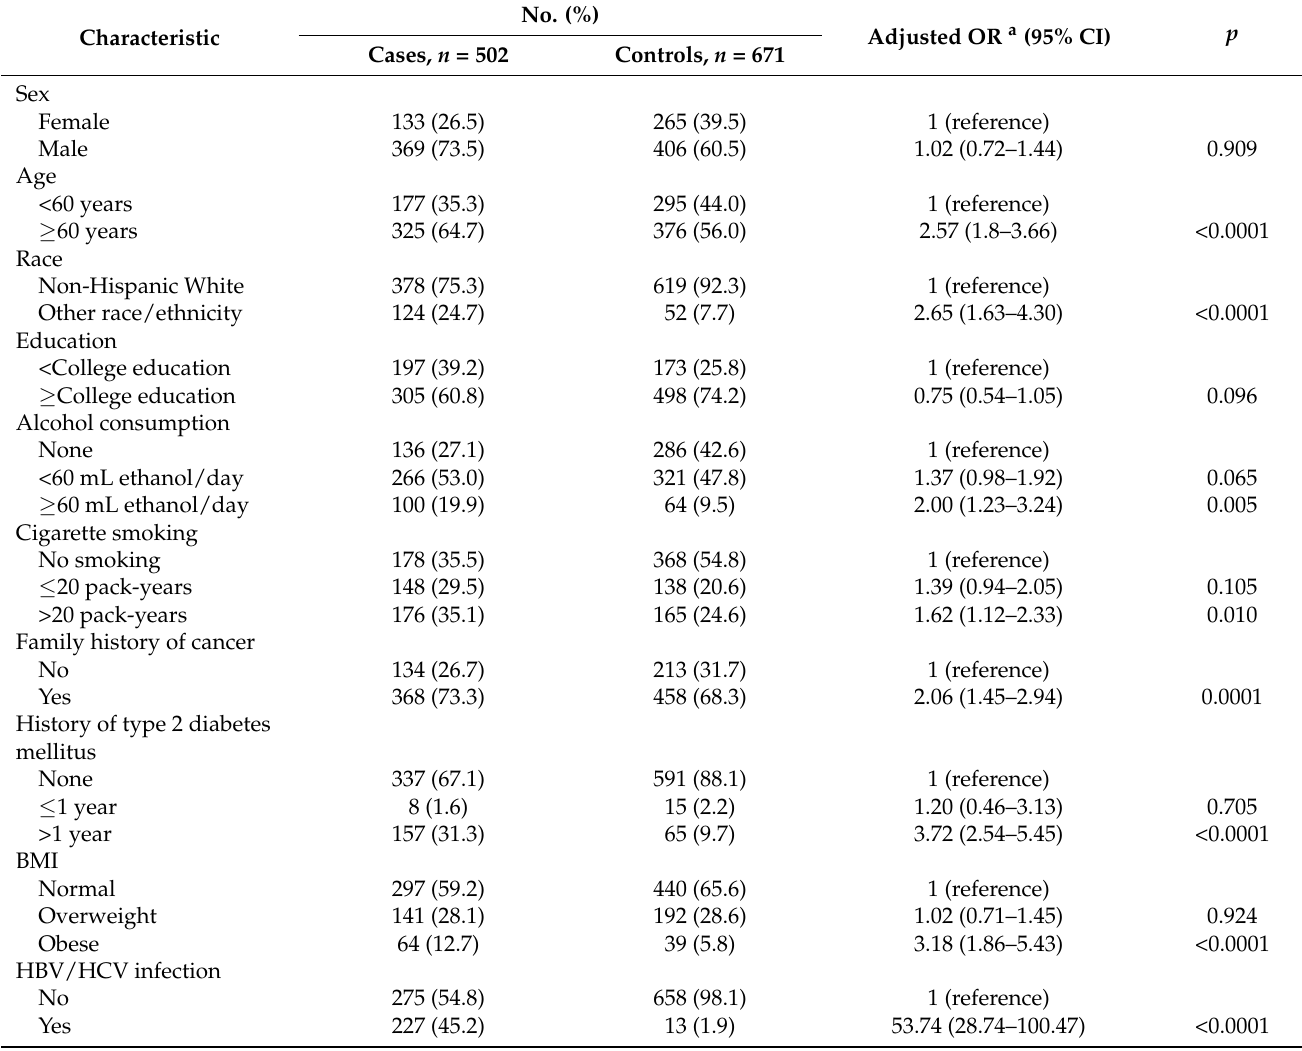
Table 3. Multivariable adjusted odds ratios (ORs) with 95% confidence interval (CI) for selected demographic factors among cases and